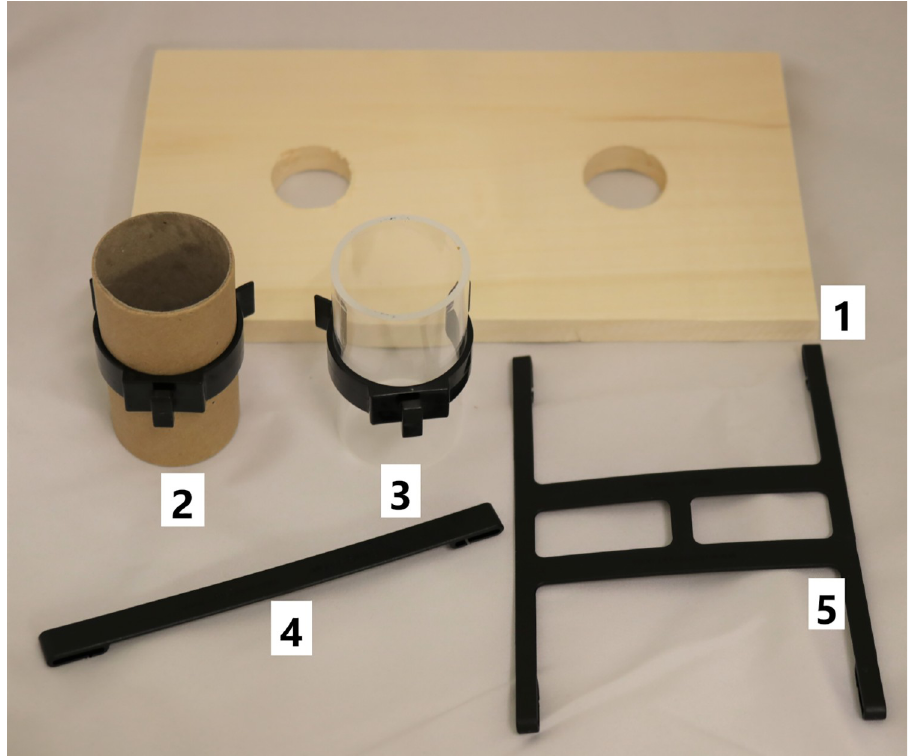
Fig 2. Enrichment items from the category structural. 1 second level 2 holes, 2 clip with paper tube, 3 clip with plastic tube, 4 mouse swing, 5 mouse swing double.